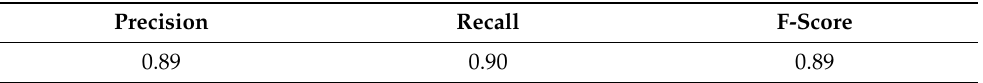
Table 7. Performance reported in [24] for random forest algorithms applied to BLUED dataset. Precision